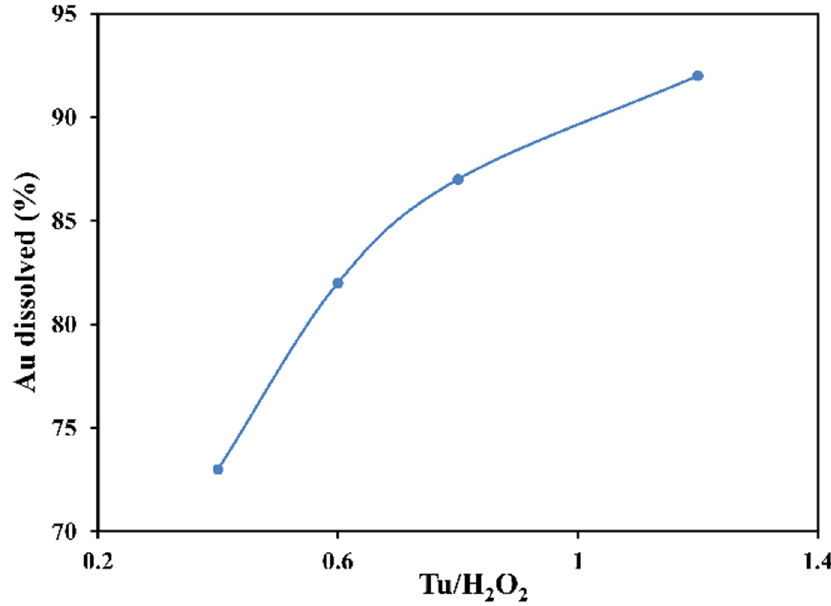
Figure 9. The effect of Tu/H 2 O 2 upon Au dissolution (experimental condition: pH: 1, 6 h, pulp density: 20 g/L).